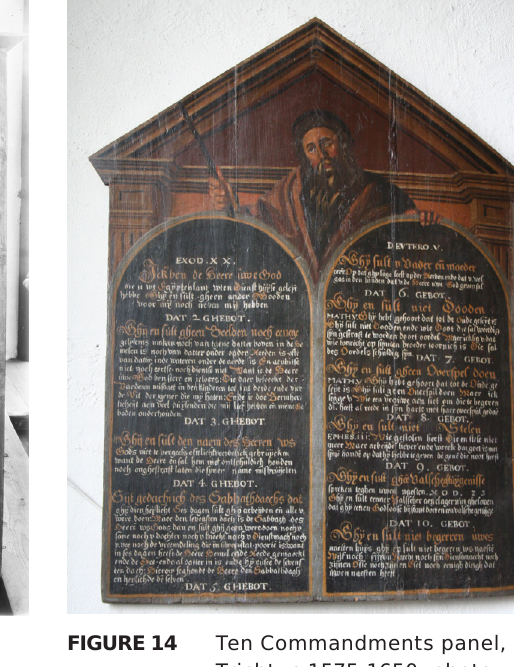
FIgure 13 Ten Commandments panel, Herveld, 1697. Collectie Rijksdienst voor het Cultureel Erfgoed, object no.